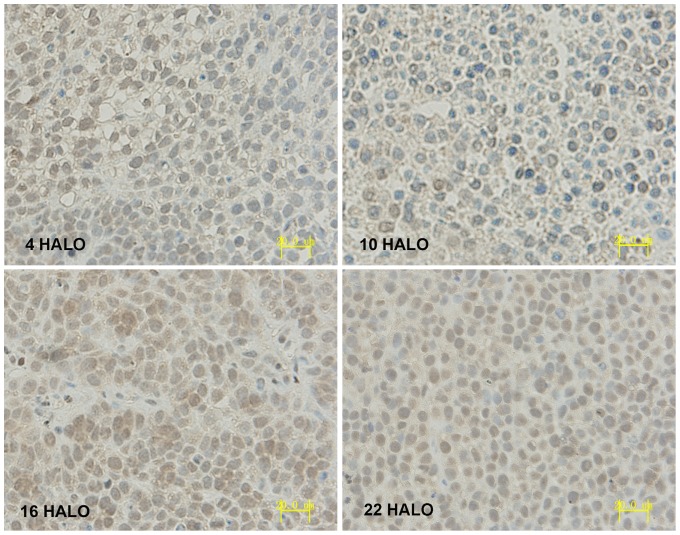
Immunohistochemical staining of PER1 protein expression in tumors of tumor bearing mice.Highest PER1 staining was seen in tumors resected at 16 HALO, while tumors resected at 10 HALO showed the minimum PER1 staining (magnification, ×400).